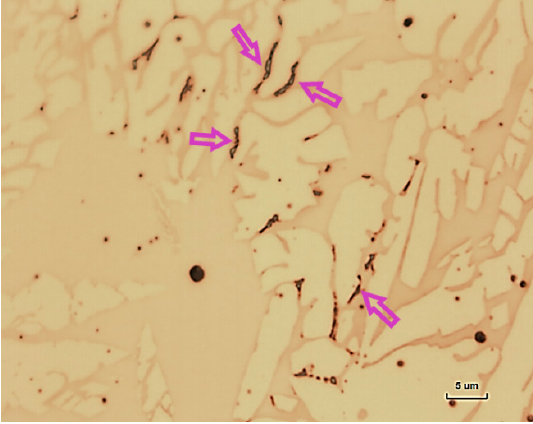
Figure 12. ( Left ) HTHAZ of Weld Pass 1 of the GH weld showing nitrides. ( Right ) HTHAZ of Weld Pass 1 of the GH weld after depositing two passes. Secondary austenite is found in locations of previous nitrides.